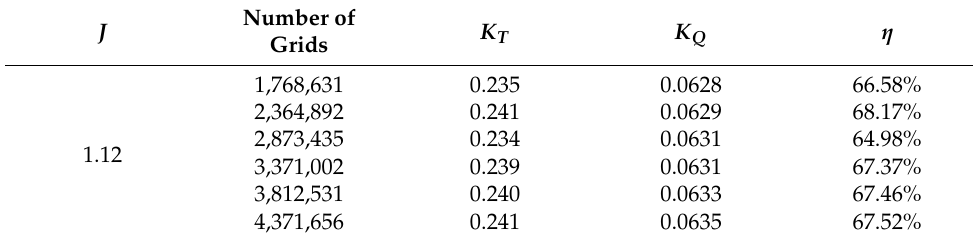
Table 5. Comparison of different grid numbers for grid independence